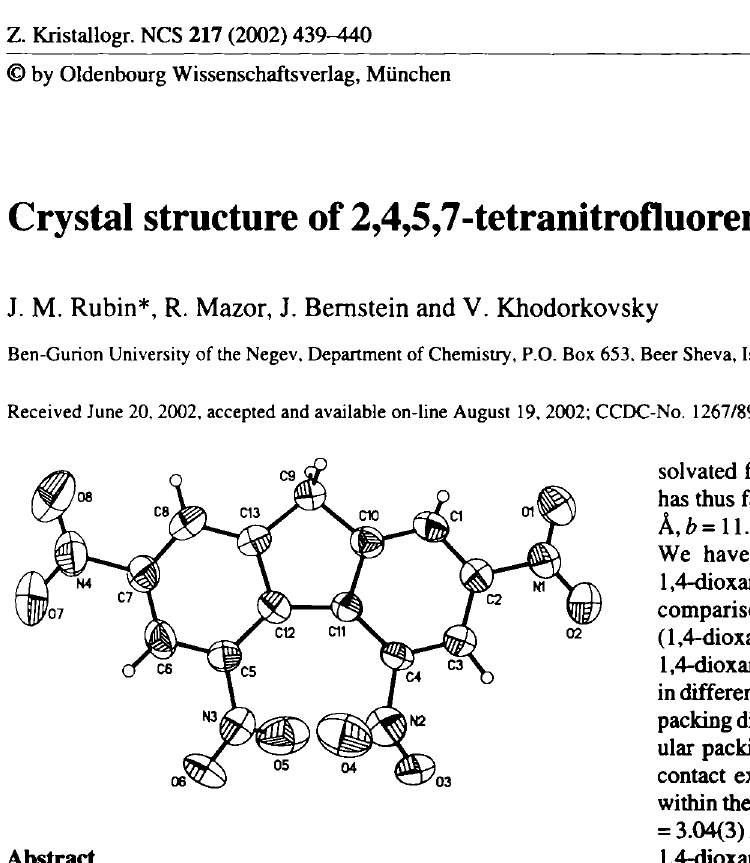
Table 1. Data collection and handling.